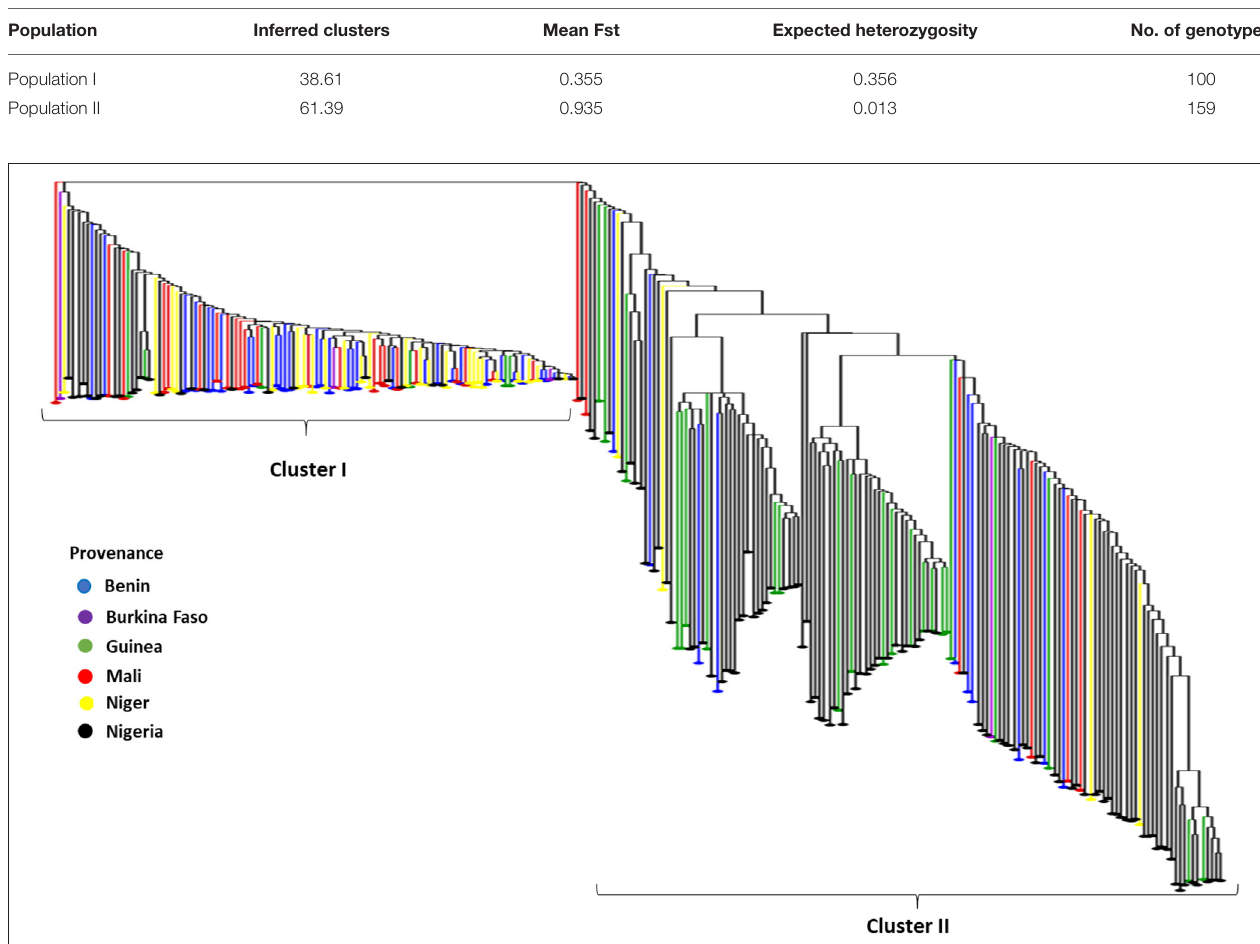
TABLE 5 | Proportion of membership, estimate of genetic diversity parameters obtained from Structure results.